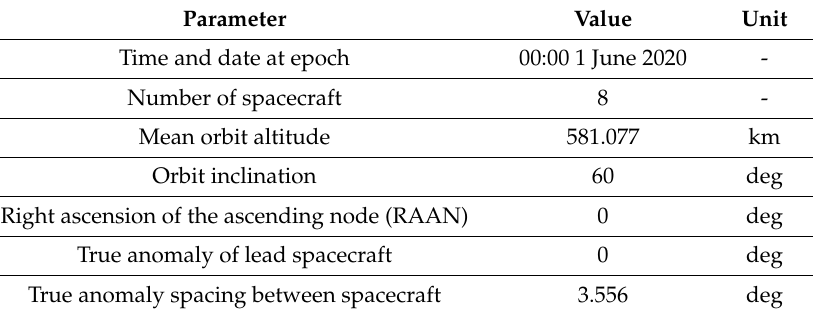
Table 5. Orbital